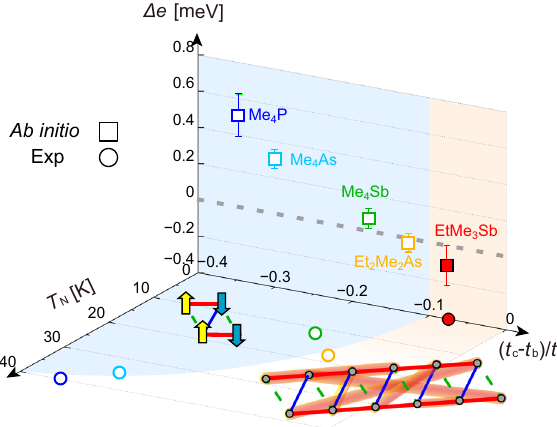
Fig. 2 Ground-state phase diagram revealed by ab initio simula- tions. Stability of electronic phases for ab initio Hamiltonians of dmit compounds, plotted for X = Me 4 P, Me 4 As, Me 4 Sb, Et 2 Me 2 As, and EtMe 3 Sb aligned from the left (small ( t c − t b )/ t a ) to the right. Vertical plane: Square symbols show the energy difference Δ e = e QSL − e AF per site between the energy of the QSL and that of the AF phases calculated for L = 16, where the energies of two lowest states, the QSL and the collinear AF states are compared. Negative Δ e indicates that the QSL is the ground state. The results with error bars were obtained after the energy variance extrapolation described in Methods. Bottom plane: Circles show the material dependence of the Néel temperature T N observed in the experiments 55,56 . For Et 2 Me 2 As and Me 4 Sb, coexistence of QSL and AF is suggested. For both planes, open symbols show the AF states and the fi lled ones are the QSL. Blue and orange shades are painted to represent the region of the collinear AF and the QSL phases, respectively for the parameter ( t c − t b )/ t a